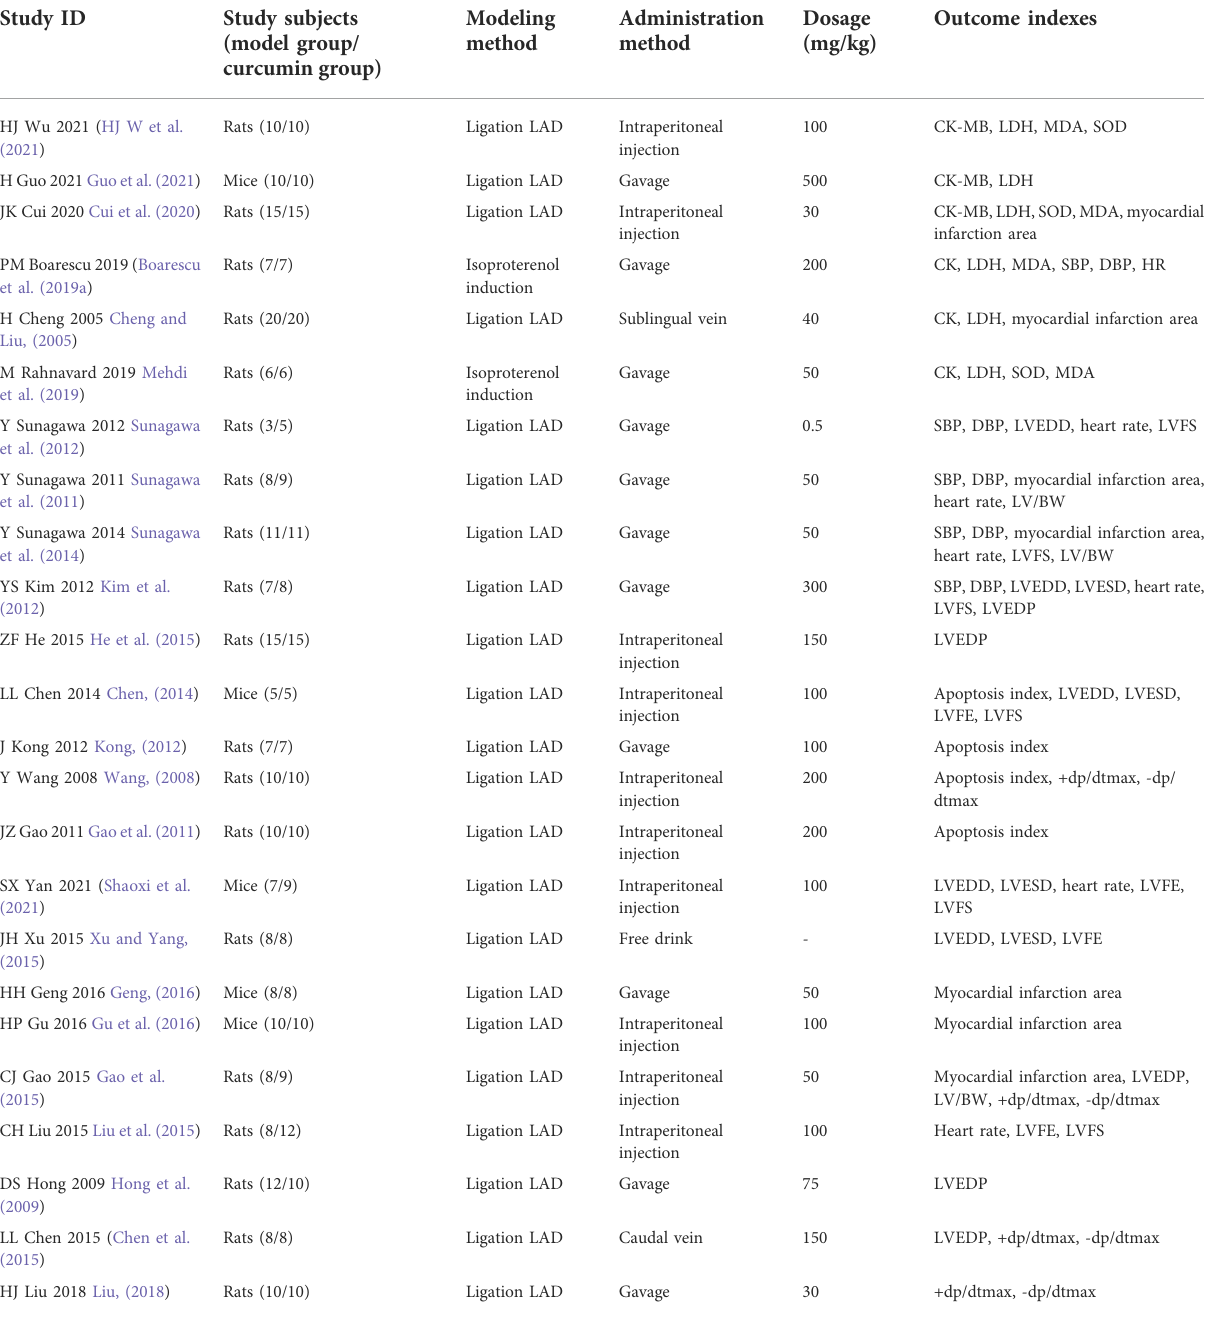
TABLE 1 Research ID, research subject, administration method and other research characteristics of included